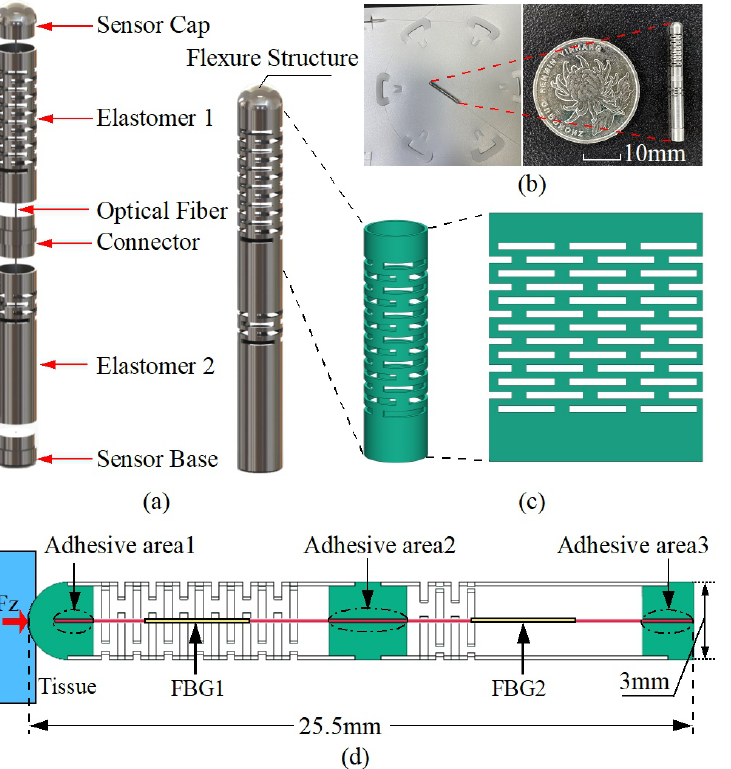
Figure 1. The schematic diagram of a dual elastomer fiber Bragg grating force sensor for cardiac catheterization. ( a ) Exploded view of the overall structure; ( b ) prototype; ( c ) multi-layer continuous beam-slots. ( d ) Detailed dimensions of the designed flexure and FBG arrangements.